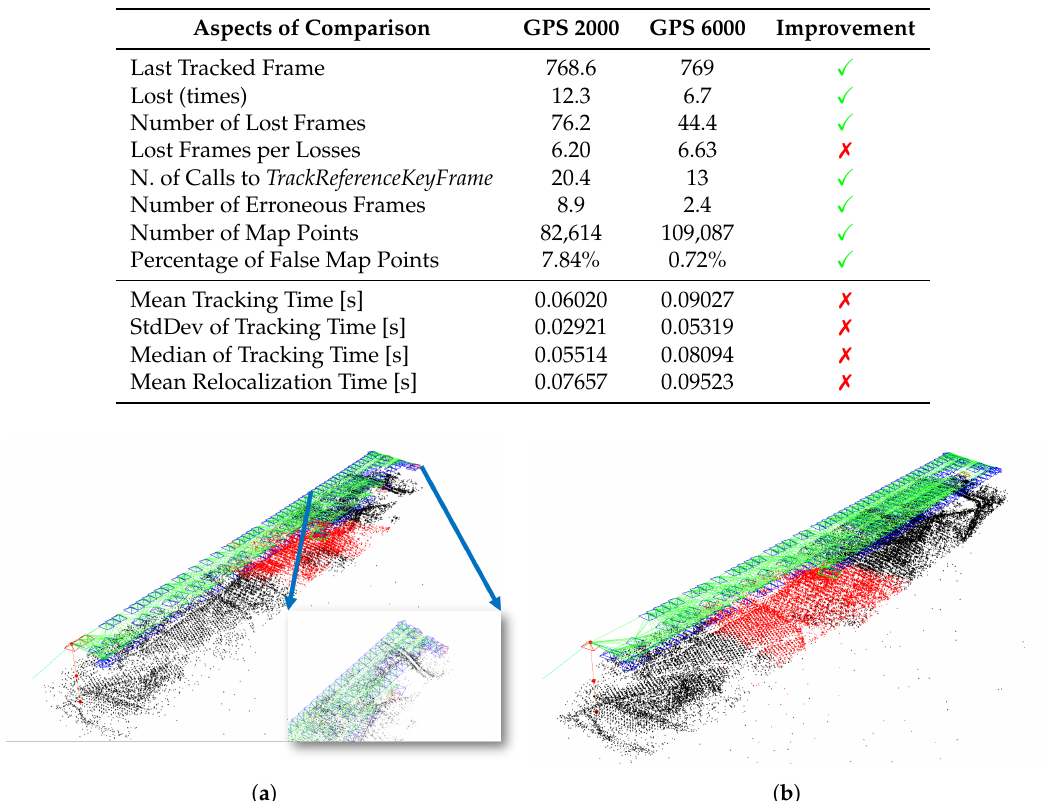
Table 4. Comparison table for the GPS-SLAM executions for 2000 and 6000. Average values for 10 executions.